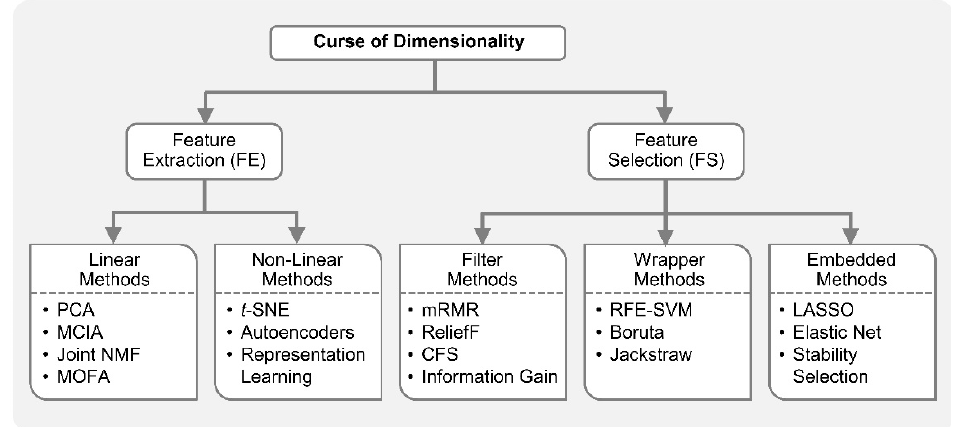
Figure 1. Machine learning (ML) with curse of dimensionality. ML-based dimensionality reduction (DR) approaches, for tackling the curse of dimensionality, can be classified into feature extraction (FE) and feature selection (FS). FE methods project data from a high-dimensional space to a lower dimensional space, while FS methods identify a small relevant subset of original features in order to reduce the dimensionality. Principal component analysis (PCA), multi-omics factor analysis (MOFA), multiple co-inertia analysis (MCIA), and joint non-negative matrix factorization (NMF) are some examples of FE methods applied in integrative analysis. These FE approaches assume linear relationships in the dataset. Nonlinear FE methods also exist including t -SNE, autoencoders, representation learning, etc. ML-based FS is broadly divided into filter, wrapper and embedded methods. Filter methods such as maximal-relevance and minimal-redundancy (mRMR), correlation-based FS (FCS), ReliefF and Information Gain are employed as a pre-processing step before training any model, while wrapper methods such as recursive feature elimination-support vector machine (RFE-SVM) and Boruta incorporate a predictive model to judge the importance of features. Embedded methods which include least absolute shrinkage and selection operator (LASSO), Elastic Net, stability selection, etc., perform feature selection as part of the model building